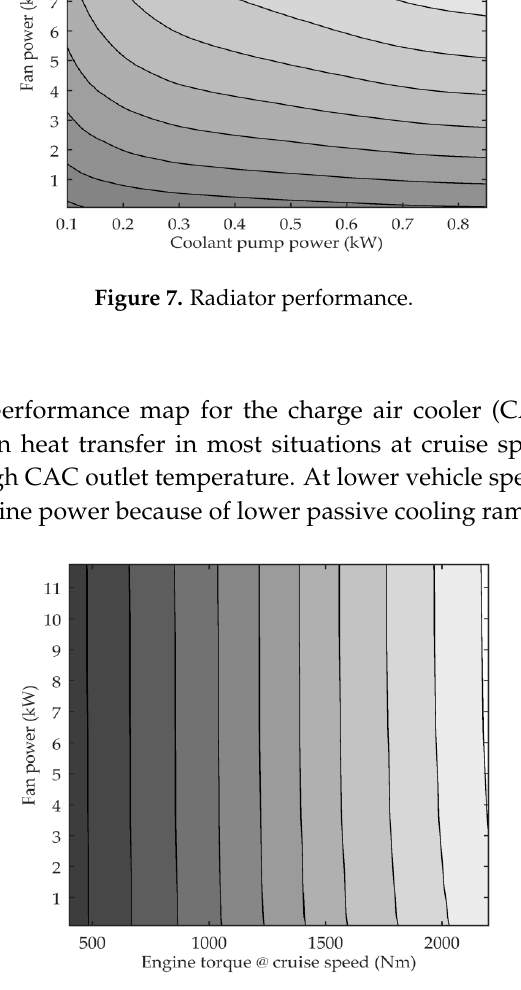
Figure 8. Charge air cooler performance .